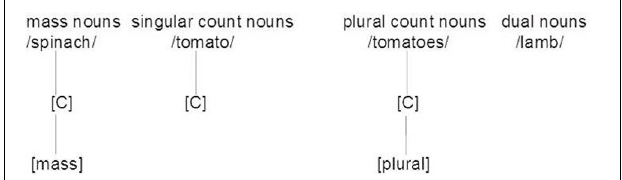
FIGURE 1 | Lexical representation of mass, count and dual nouns adapted from Taler and Jarema (2006, Figure 4, page 49).